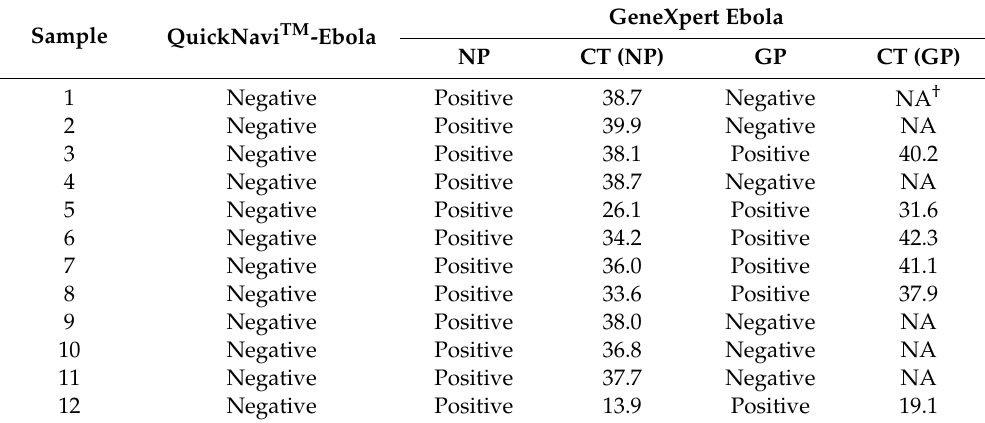
Table 3. Details of QuickNavi TM -Ebola-negative samples in PCR-confirmed